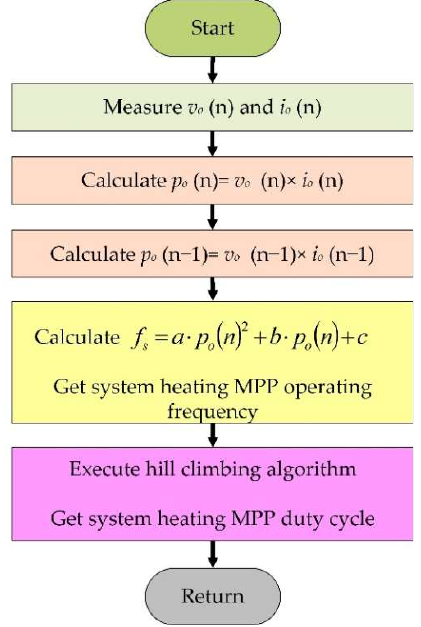
Figure 17. Flow chart of the proposed MPPT heating strategy.